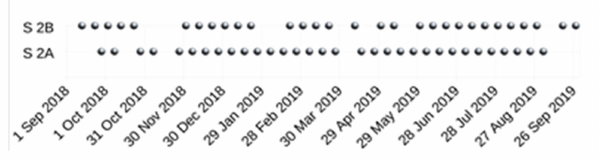
Figure 2. Temporal distribution of the Sentinel 2A and B